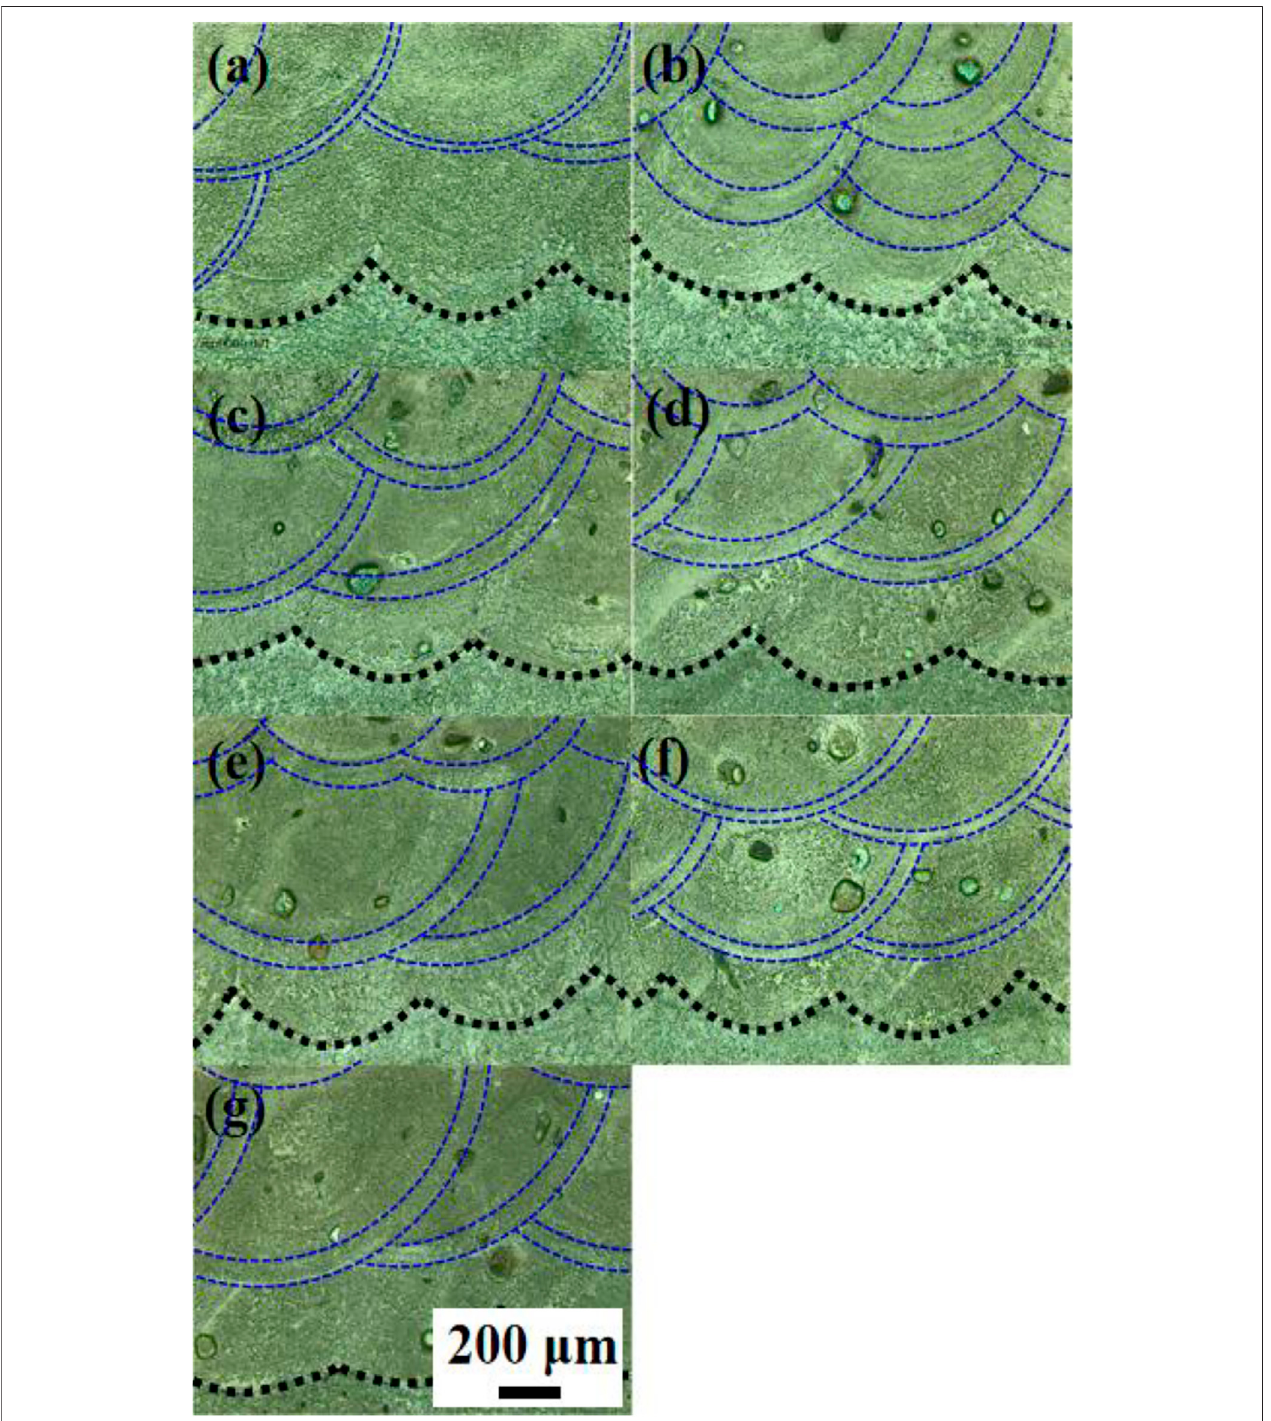
FIGURE 3 | Metallographic morphology of different samples in the building direction. (A) 10 – 0 sample; (B) 10 – 2 sample; (C) 8 – 2 sample; (D) 6 – 2 sample; (E) 4 – 2 sample; (F) 2 – 2 sample; and (G) 0 – 2 sample.